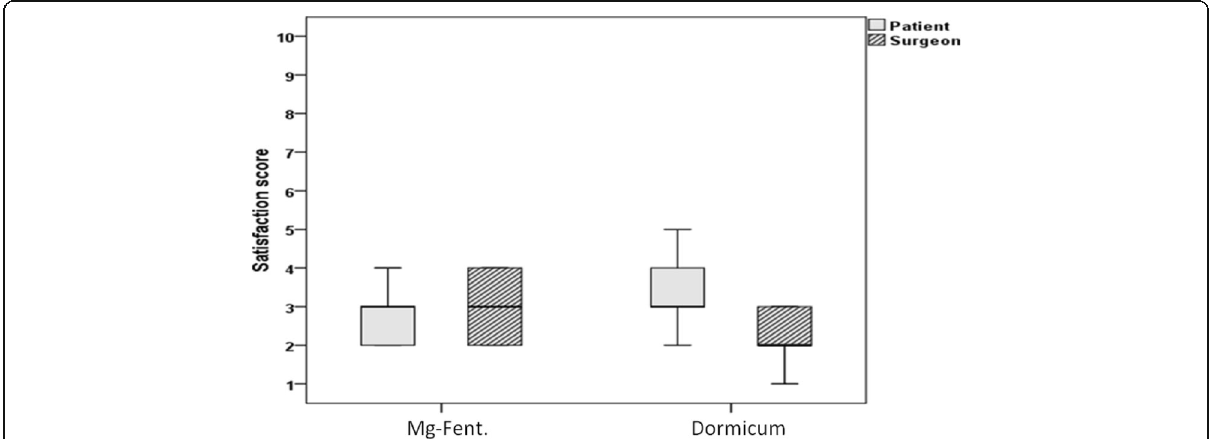
Fig. 7 Box plot showing patient and surgeon satisfaction scores in both study groups. Box represents interquartile range. Line across box represents median. Error bars represent minimum and maximum